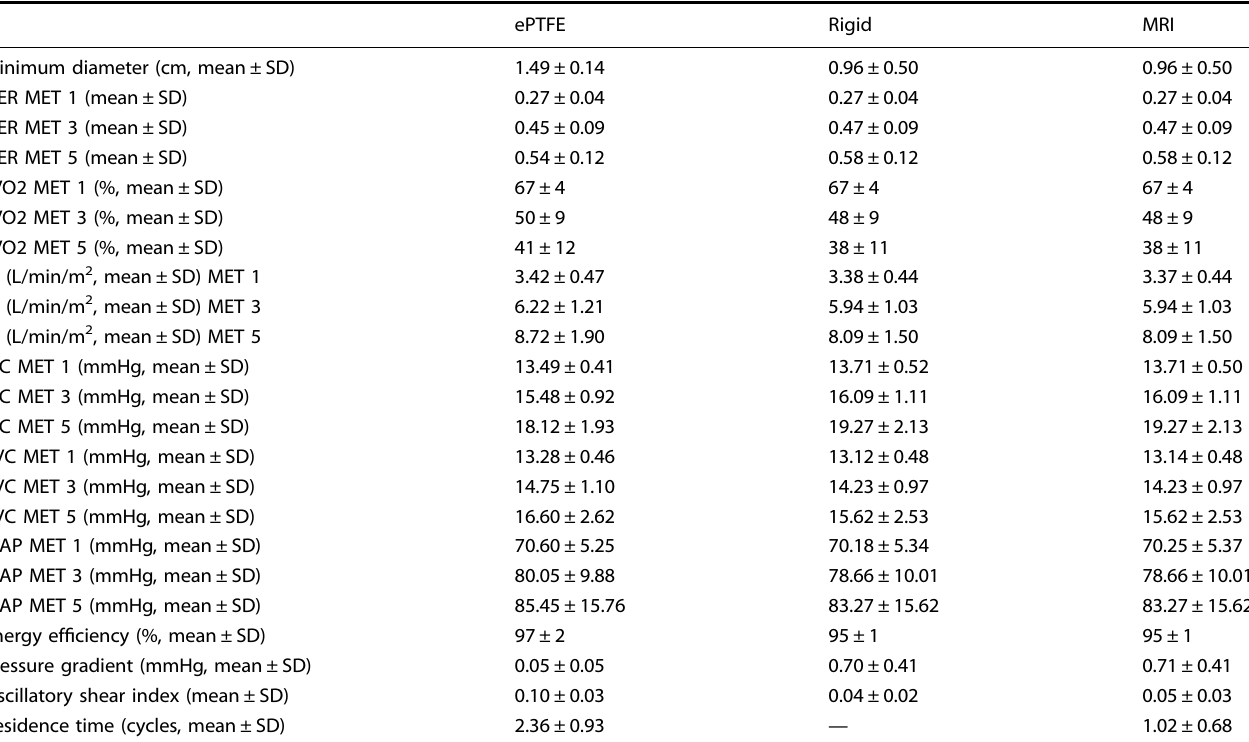
Table 2. Physiologically relevant metrics derived from CFD simulations; results are summarized for a ePTFE (16 mm diameter), rigid wall TEVG, and TEVG geometry from MRI at 6 months and 3 years post-Fontan operation